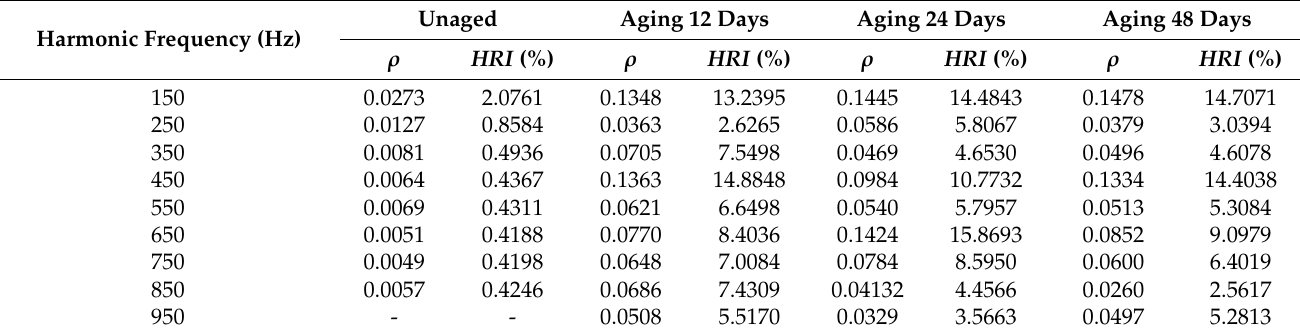
Table 1. The ρ and HRI between each order of harmonics and leakage current.